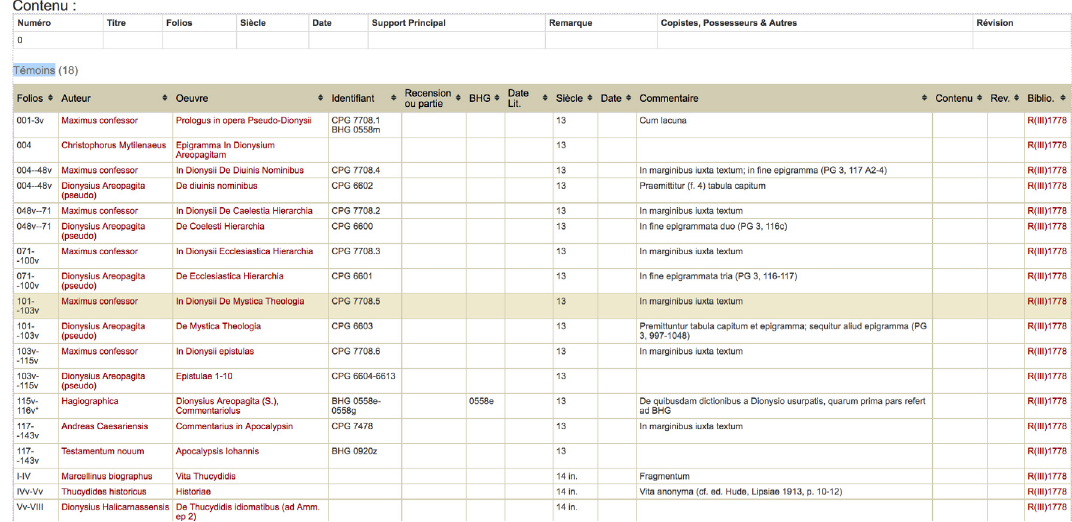
Figure 9. Contents of GA 2042 (dikyton 45988) in